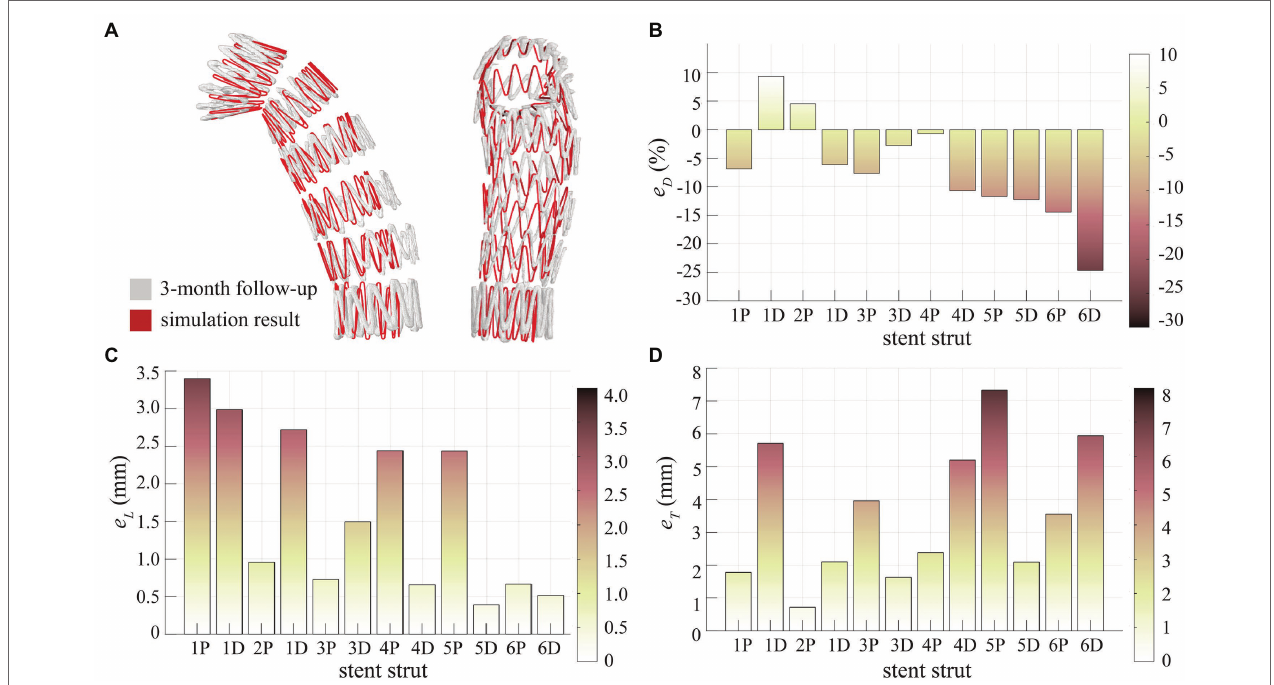
FIGURE 4 | Assessment of SG configuration. (A) Superimposition of the SG from simulation result and 3-month follow-up scan, (B) diameter difference ( e D ) at the stent strut ends, (C) longitudinal positioning deviation ( e L ) at the stent strut ends, and (D) transverse positioning deviation ( e T ) at the stent strut